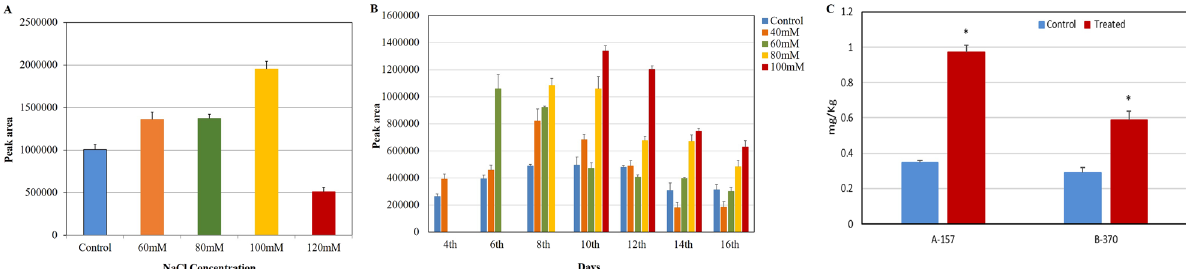
Figure 1. Optimization of ( A ) NaCl concentration, ( B ) period of treatment at 100 mM NaCl for maximum 2AP synthesis in the leaf tissue of A-157 rice cultivar ( C ) Quantification of 2AP in salt-treated plants leaf tissue in aromatic rice